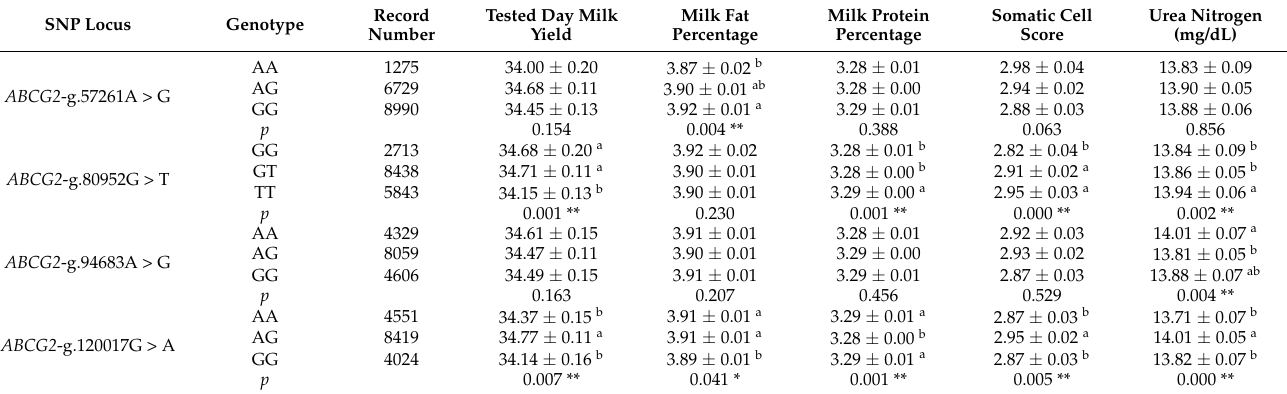
Table 4. Effects of different genotypes of SNPs of ABCG2 gene on production performance of Holstein.